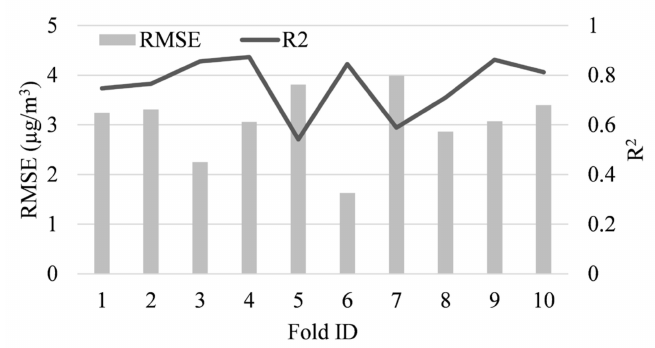
Figure 9. Accuracy assessment of the developed model using tenfold cross-validation. The measure- ment RMSE ( left ) and R 2 ( right ) are